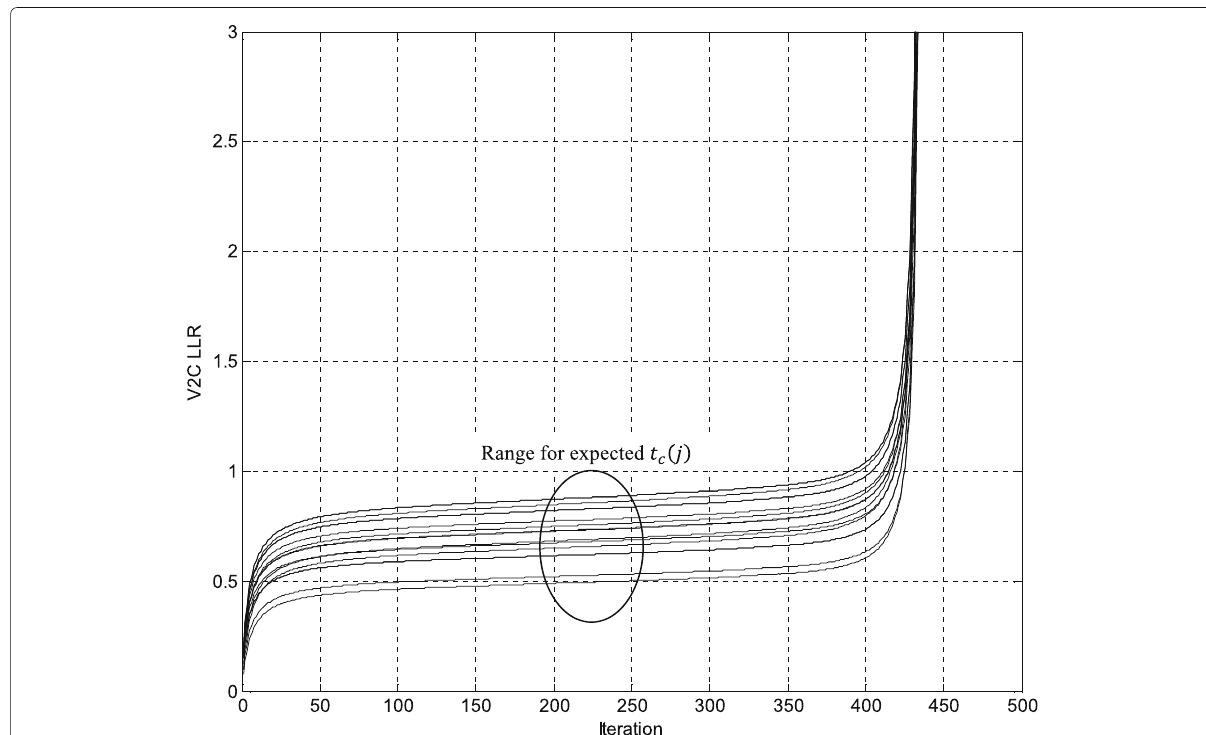
Fig. 8 Average V2C LLR curve for each type of variable node when a rate-1/2 LDPC code specified in IEEE 802.11ad is used